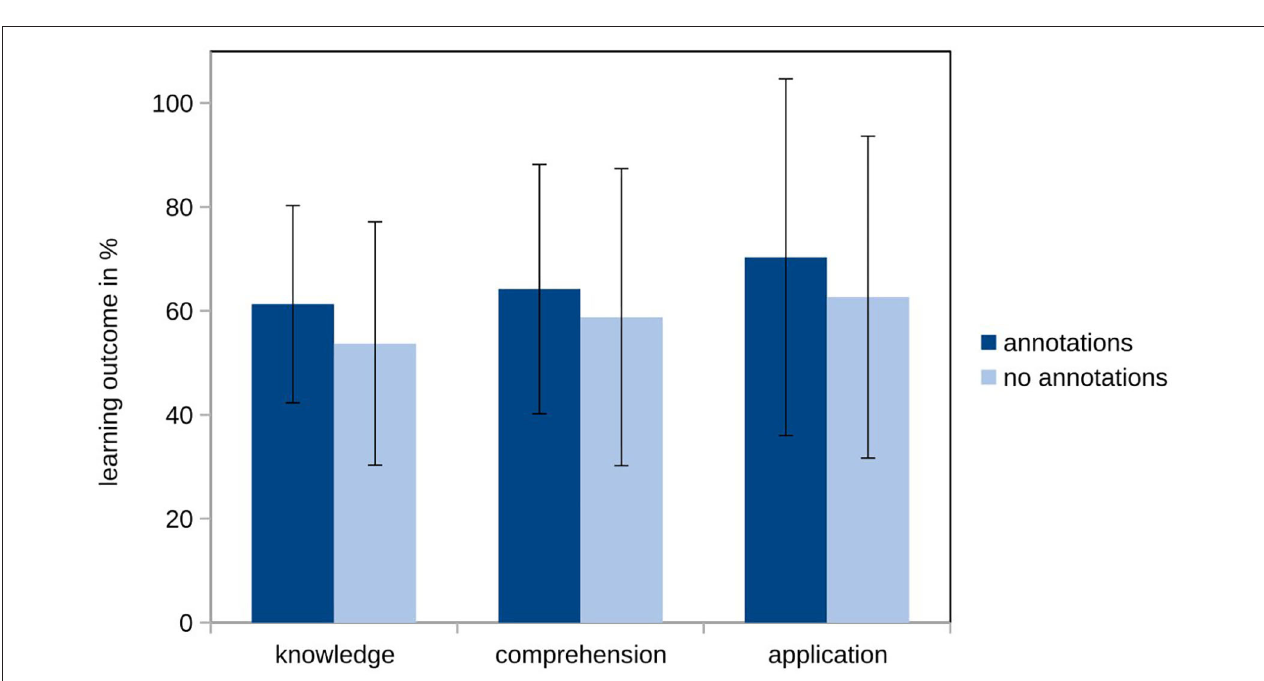
FIGURE 2 | Means and standard deviations of the learning outcome on the three levels knowledge, comprehension and application of the two conditions.